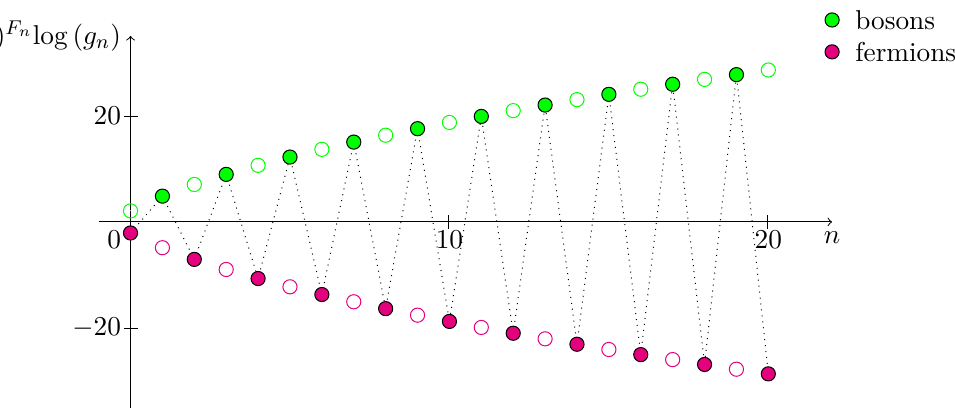
Figure 1 . The net number of bosonic and fermionic physical degrees of freedom for the lightest energy levels for an anti-D p -brane on top of an O p -plane, defined as ( − 1) F n g with N ( n ) and N ( n ) being the number of bosonic and fermionic states at the n -th mass level. Each b f point corresponds to states with mass M 2 = n/α 0 , with n = 0 , 1 , . . . , 20 . Filled points correspond n to states that are invariant under the orientifold projection, whereas empty dots represent states that would be there if the anti-D p -brane was at a smooth point, with a supersymmetric matching in the bosonic and fermionic degrees of